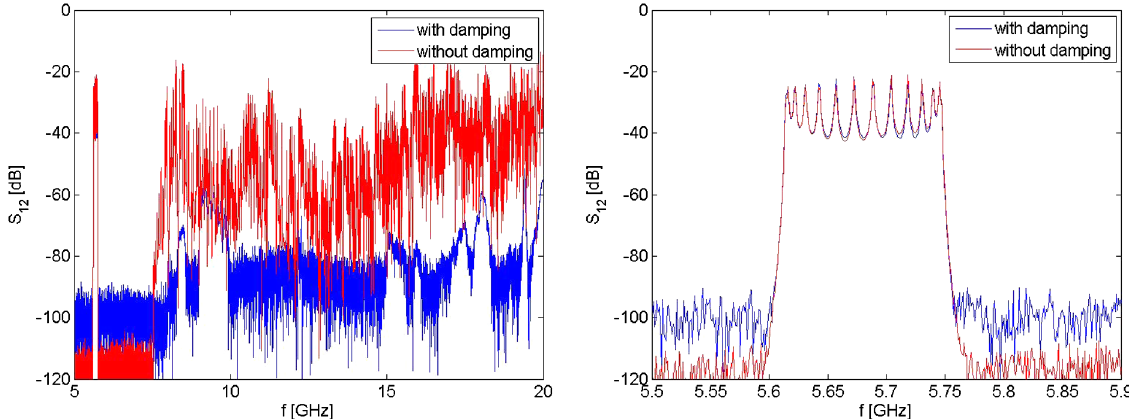
FIG. 14. Transmission coefficient between two antennas coupled to a 12-cell module with and without the absorbers (left); detail of the transmission coefficient corresponding to the bandwidth of the accelerating mode (right)